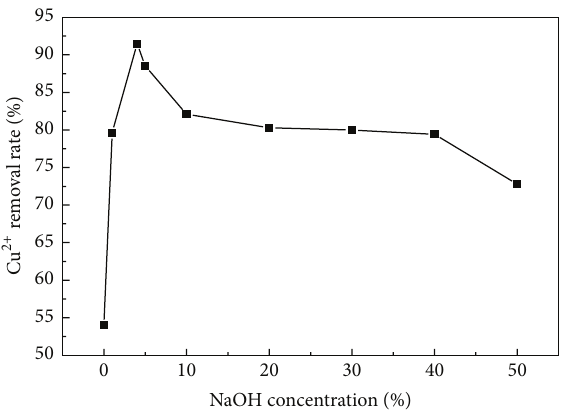
Figure 2: Effect of NaOH operation time (conditions: adsorbent dose = 5 g/L, adsorbate conc. = 20 mg/L, pH = 5, contact time = 6 h, temp. = 25 ± 1 ∘ C, and stirring rate = 150 rpm).